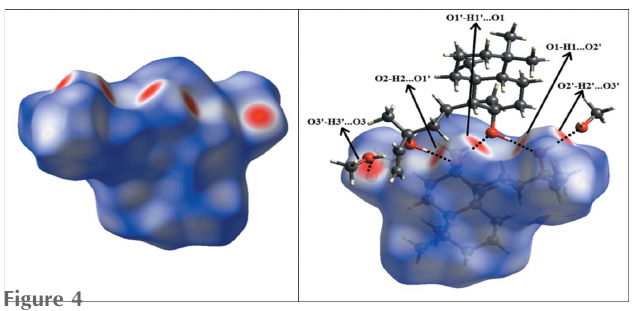
Figure 4 Hirshfeld surface mapped over d norm of 1 with neighboring molecules linked via O—H (cid:2)(cid:2)(cid:2) O hydrogen bonds (dashed lines).